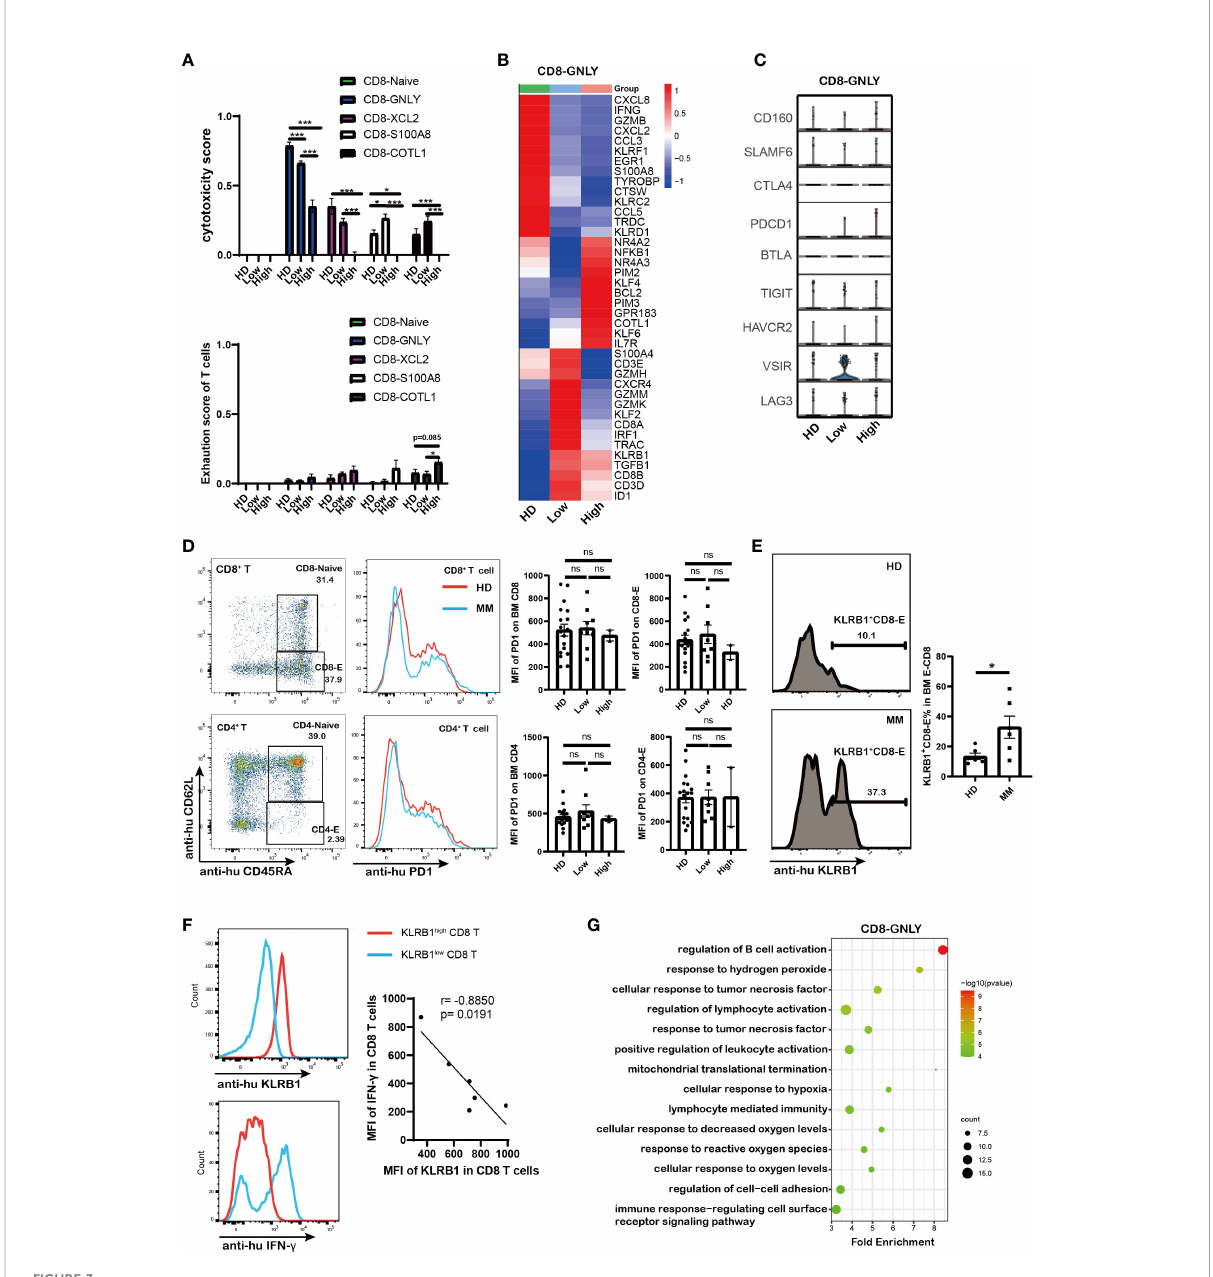
FIGURE 3 Dysfunction of CD8 T cells in high tumor burden group was associated with PIM kinases and KLRB1 as well as the abnormal metabolism mediated by MM (A) . Bar charts shows the cytotoxicity scores and exhaustion scores of CD8 + T cells from HD and MM patients in different in fi ltration groups (HD: n=6; Low: n=6; High: n=6). (B) . Heatmap shows the DEGs in CD8-GNLY among HD and MM patients in different in fi ltration groups (HD: n=6; Low: n=6; High: n=6). (C) .Violin plots display gene expression of classical immune checkpoints in CD8-GNLY cell clusters from HD and different MM conditions (HD: n=6; Low: n=6; High: n=6). (D) . Flow cytometry analysis shows the expression of PD1 on bone marrow CD8 + T cells and CD4 + T cells from HD and MM patients (HD: n=18; Low: n=8; High: n=2). (E) . Flow cytometry plots and bar chart show the proportion of KLRB1 + CD8 + -Effector T cells in CD8-Effector cells from HD and MM patients (HD: n=6; Low: n=6). CD8-Effector: CD3 + CD8 + CD45RA + CD62L - ; (F) . Flow cytometry plots and dot plot show the correlation between KLRB1 expression and IFN- g expression in CD8 T cells from MM patients activated by Cell Activation Cocktail (with Brefeldin A) in vitro . (n=6) (G) . Scatter plot of Gene Ontology (GO) Enrichment statistics shows the enriched GO terms in DEGs of CD8-GNLY among HD and MM groups. The y-axis indicates different GO terms and the x-axis indicates the Fold Enrichment. The color and size of the dots represent the range of the – log10 (p value) and the number of DEGs mapped to the indicated pathways, respectively. DEGs, Differentially expressed genes. In all instances, p < 0.05 was considered signi fi cant, * p < 0.05 and *** p < 0.001. ns, no signi fi